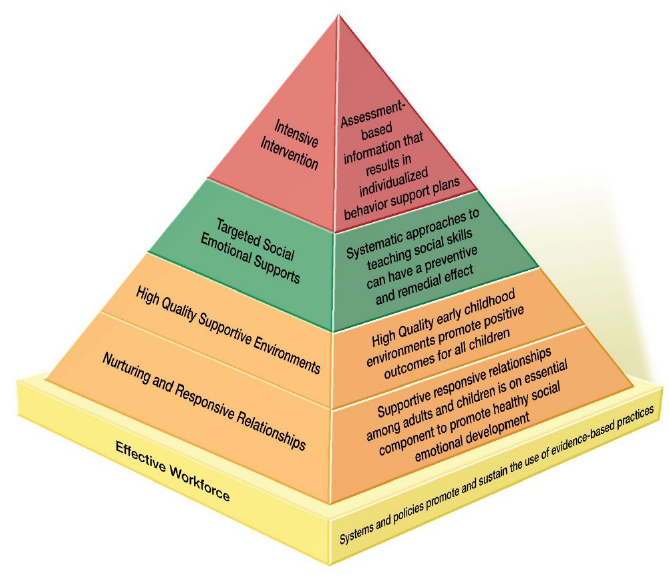
Fig. 2 Conceptual model of college students’ entrepreneurial